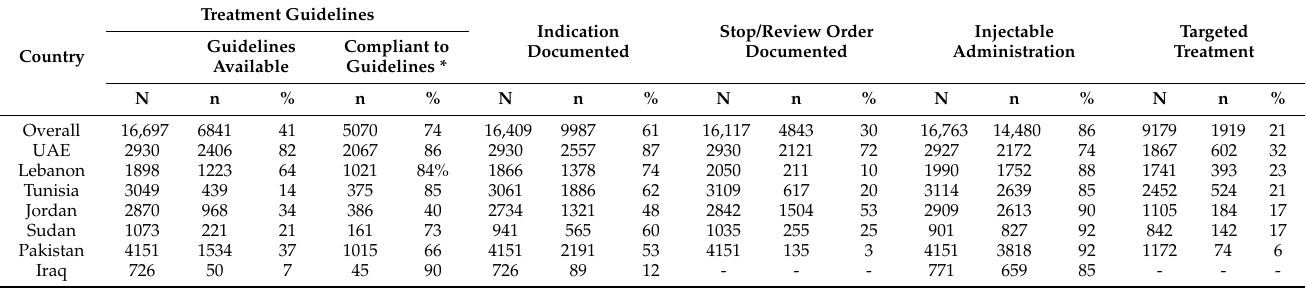
Table 2. Quality indicators of antimicrobial prescribing, seven countries in the Eastern Mediterranean Region, 2019.